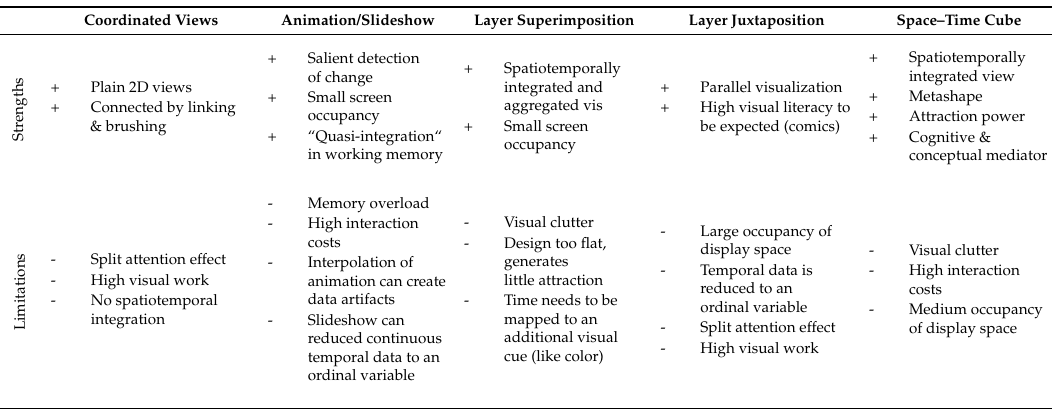
Table 1. Visual–analytical strengths and limitations of spatiotemporal representation